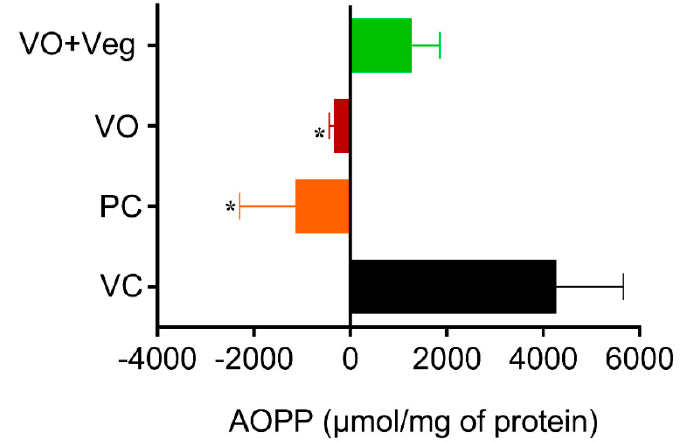
Figure 9. Delta levels of advanced oxidation protein products (AOPP) in skin experimental groups. Data are expressed as mean ± SEM * p < 0.05. One-way ANOVA followed by Tukey’s post hoc test.